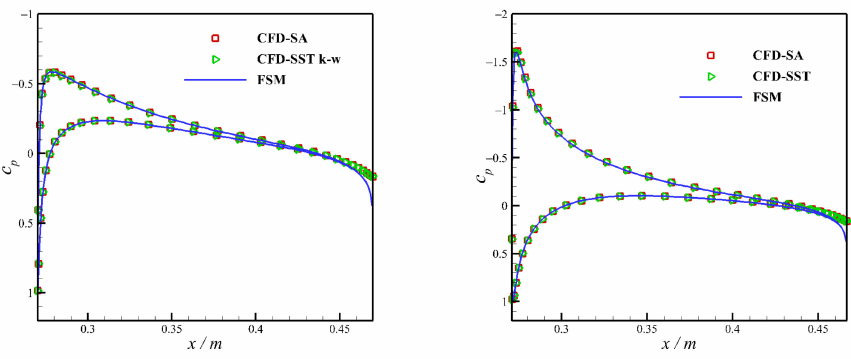
Figure 13. Comparisons of pressure coefficient of airfoil with different methods.